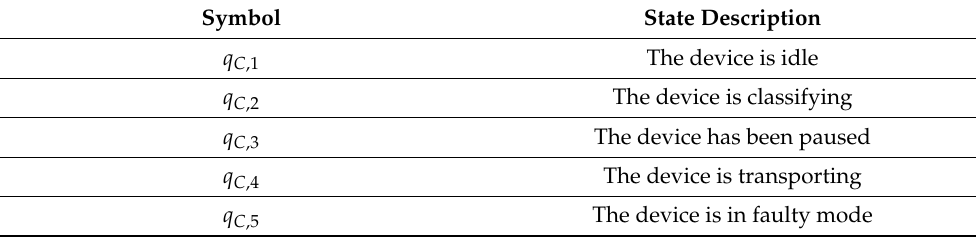
Figure 2. The state diagram of G T . Table 3. States of the classifier and transportation device.